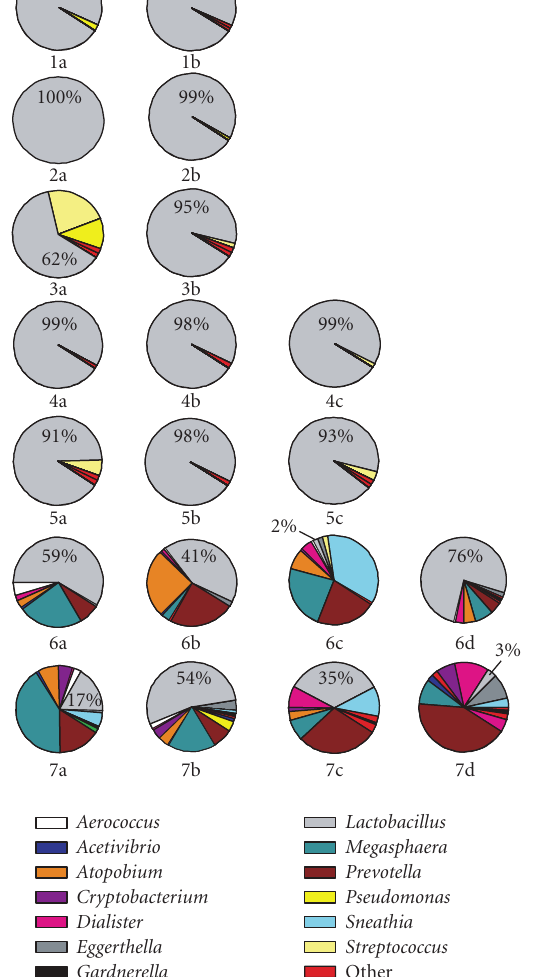
Figure 1: Pie chart representations of the vaginal microbial community structure between participants (top to bottom) and within each participant, over time (left to right) as inferred by 16S rRNA gene libraries. The percentage of each library consisting of clones related to members of the Lactobacillus genus is